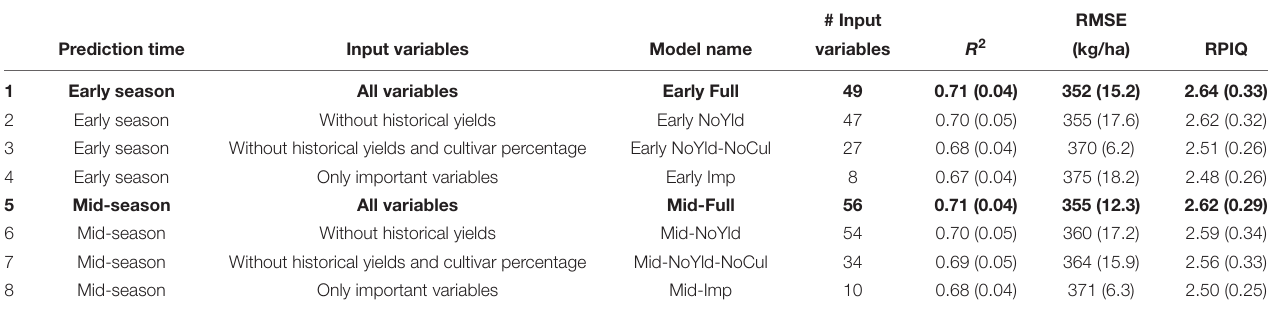
TABLE 3 | Performance of the Stochastic Gradient Boosting (SGB) approach in predicting the almond yield at individual orchards, using different set of input variables, as shown by the statistics from a four-fold